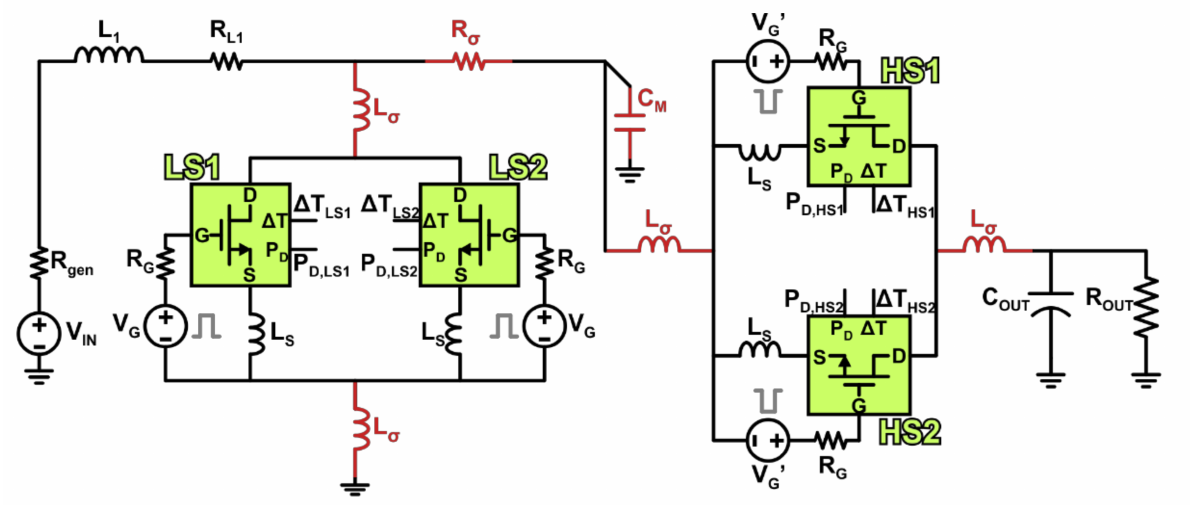
Figure 6. Schematic of the half-bridge circuit driven in a synchronous step-up configuration. The light green boxes are the transistor subcircuits depicted in Figure 3, while the parasitics are modeled with the passive components drawn in